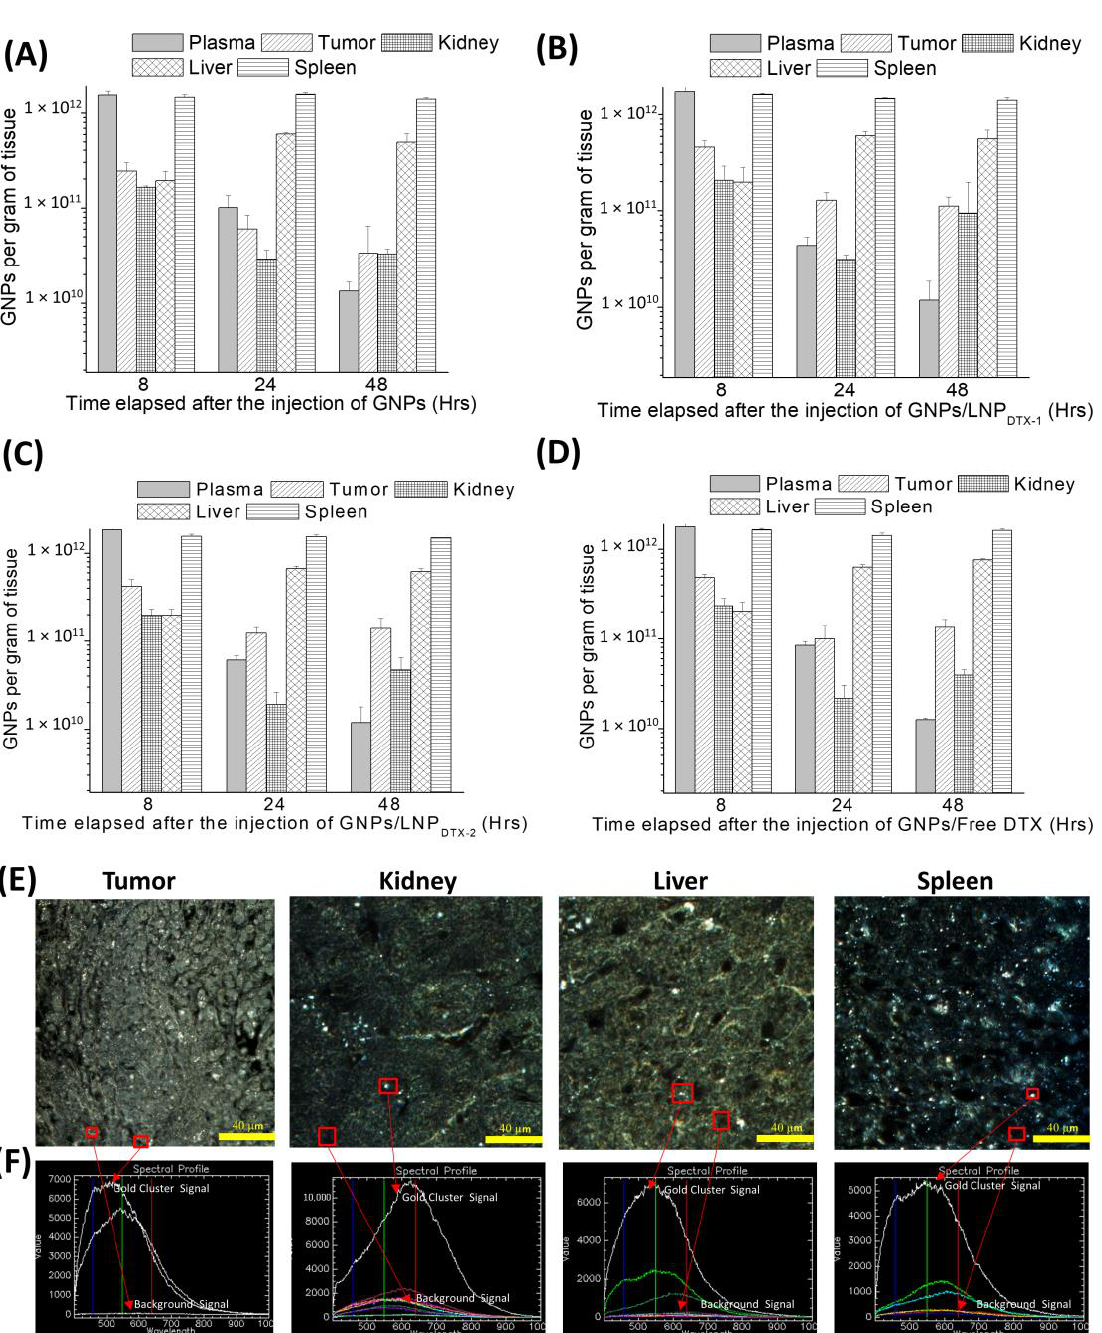
Figure 5. Gold nanoparticle (GNPs) uptake in in vivo tumour tissues and organs. ( A – D ) GNP amounts per gram of tissue for untreated mice, mice treated with LNP DTX-1 , mice treated with LNP DTX-2 , and mice treated with free DTX, respectively. ( E ) Darkfield images of 4 µm sections of tumour tissue, kidney, liver, and spleen 24 h after LNP DTX-1 treatment. ( F ) Hyperspectral spectra of GNPs within their respective tissues. Scale bar: 40 µm.